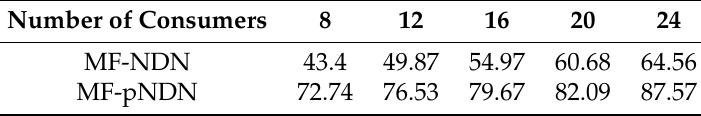
Table 2. Percentage of Data packets retrieved via the 802.11 OCB face over the total number of